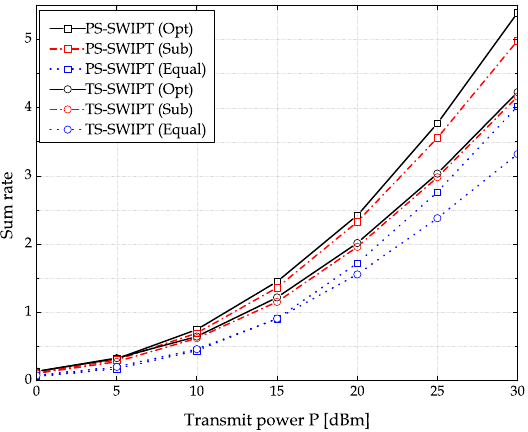
Figure 7. Sum rate of the PS-SWIPT and the TS-SWIPT as a function of P dBm when ν = 3 and d 1 / D =